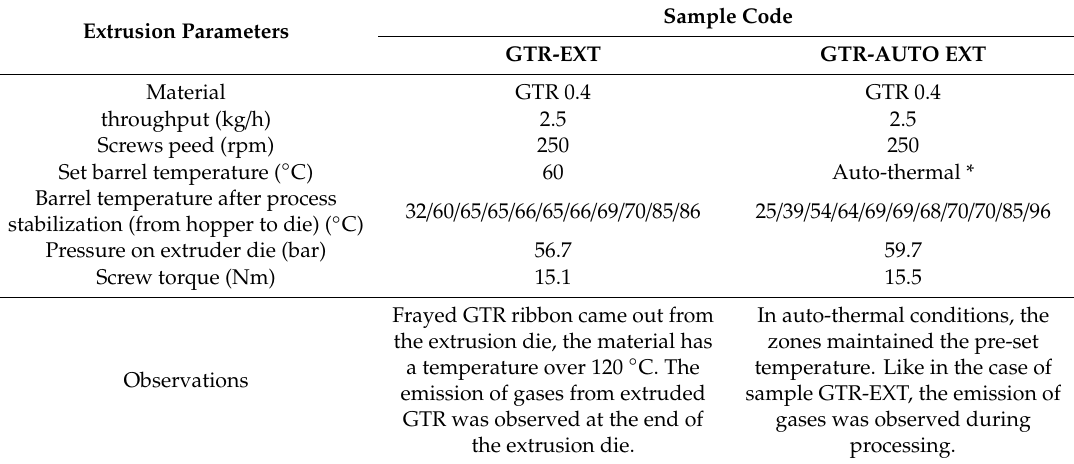
Table 1. Extrusion conditions of ground tire rubber (GTR).